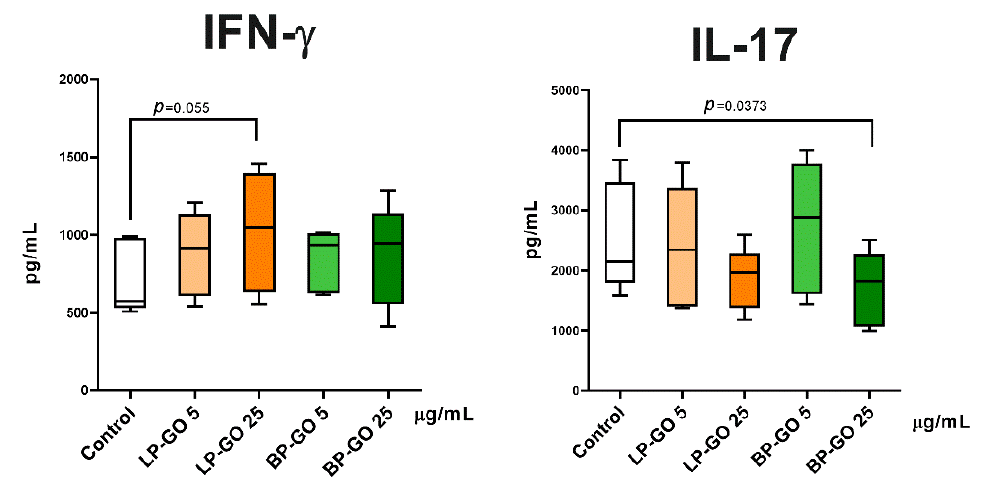
Figure 10. Production of IFN- γ ( left ) and IL-17 ( right ) by TCR-activated CD4+ cells polarized in the Th17 phenotype supplemented with pegylated GO particles at two concentrations. Note: x -axis indicates nanoparticle type and concentration of nanoparticles; the y -axis indicates cytokine concentration. Control—culture without GO. Data are expressed as median (Me) and quartiles (Q1–Q3). Significant differences ( p < 0.05) compared with control are indicated.